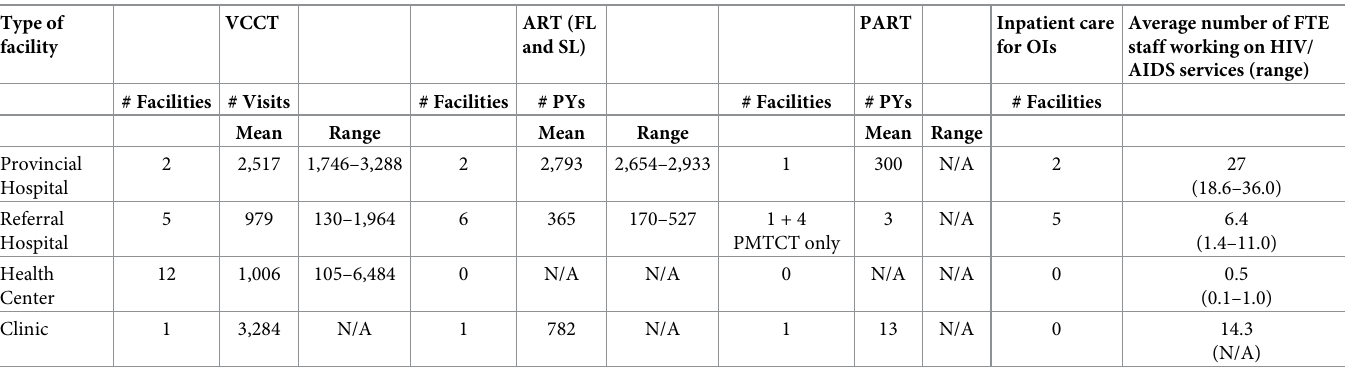
Table 1. Number of facilities in sample offering selected